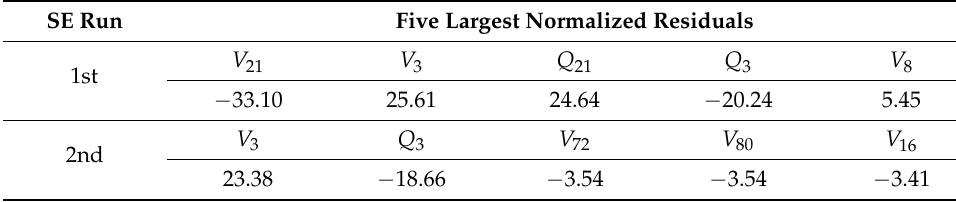
Table 5. Normalized residual test to identify bad